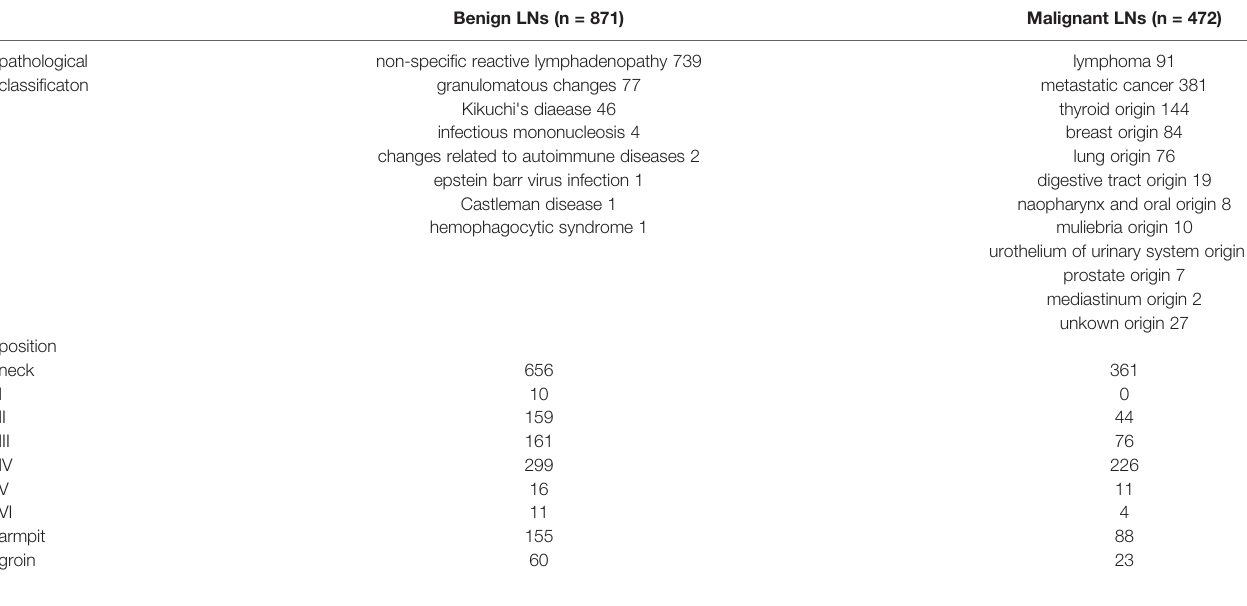
TABLE 1 | Types and locations of benign and malignant lymph